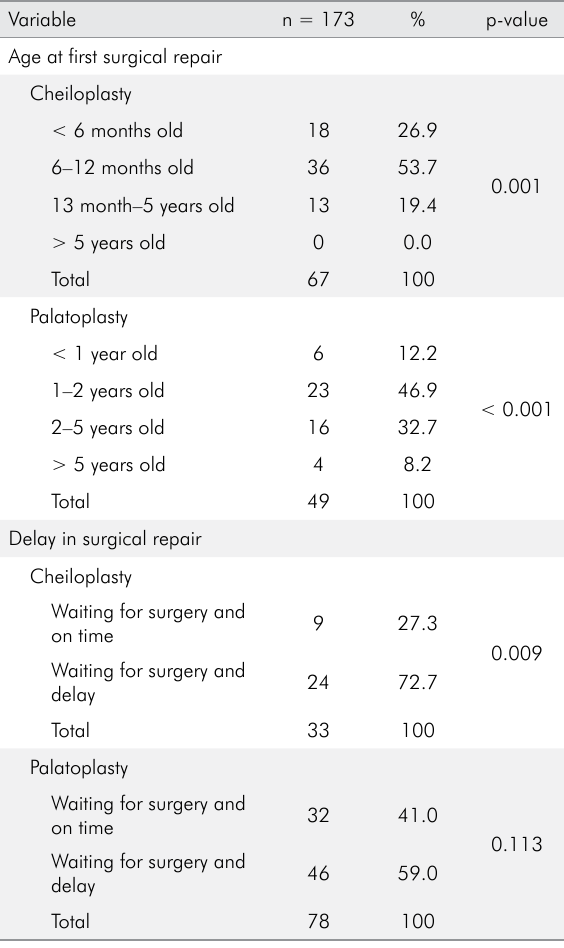
Table 3. Data on parents of orofacial cleft patients. Table 2. Data on lip and palate surgical repair.